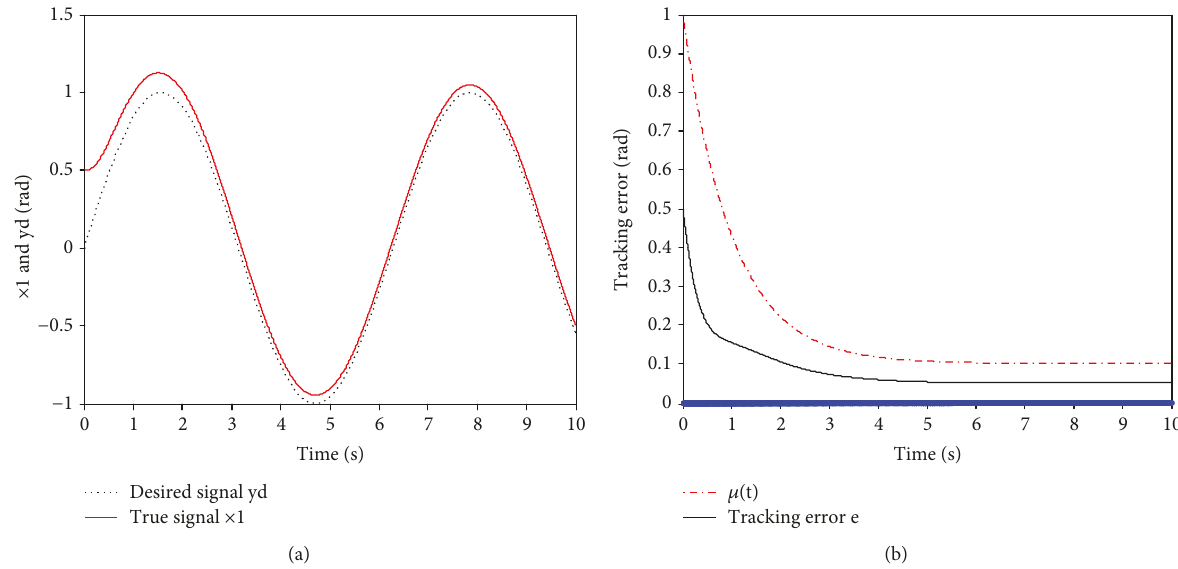
= 0 1 , δ = 0 5 , γ = 10 , and η = 5 : ∞